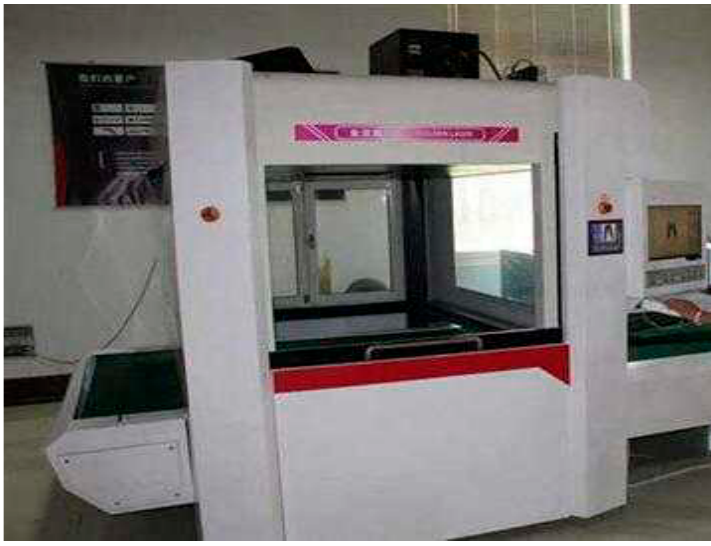
Figure 1. Picture of our laser machine.